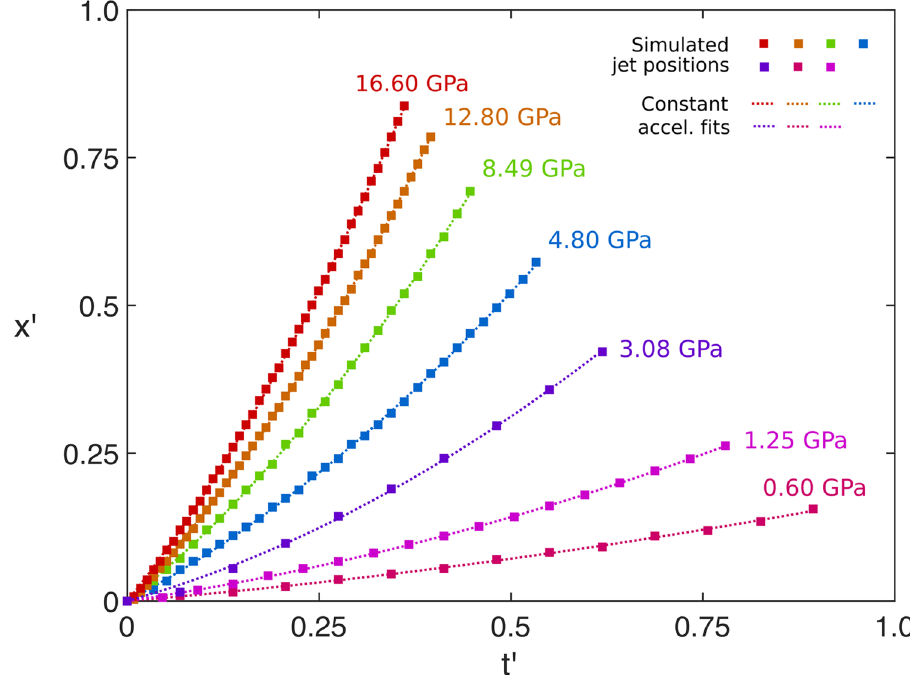
Figure 8. Plots of x ′ vs. t ′ extracted from simulations in Hytrac, with constant-acceleration quadratic